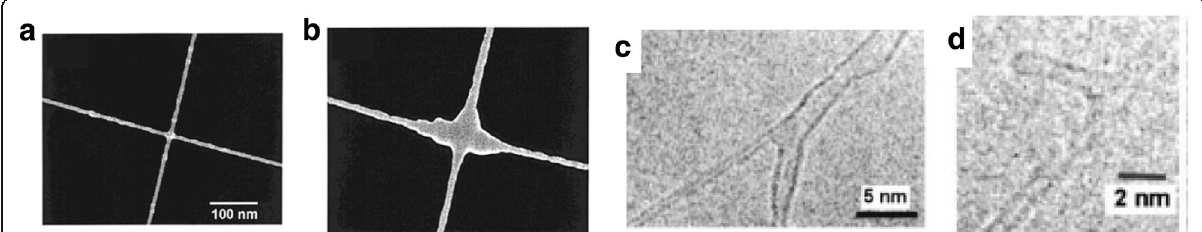
Fig. 19 Growth of a MWCNT nanotube junction ( a ) before and ( b ) after soldering by deposition of amorphous carbon via electron beam irradiation. Adapted from [163]. c Y-shaped junction formed by electron beam irradiation. Adapted from [162]. d T-shaped nanotube junction formed after irradiating a preformed Y junction. Adapted from